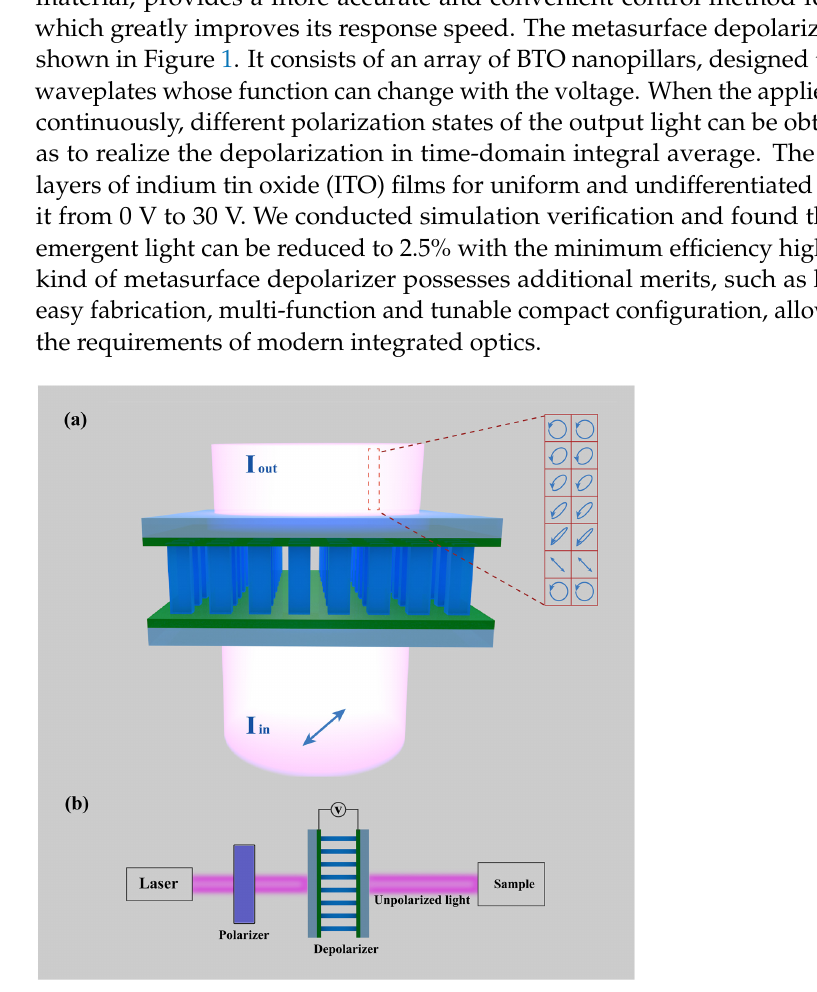
Figure 1. The schematic of the metasurface depolarizer. ( a ) The incident light is linearly polarized light with polarization direction angle π= 4 α , and after passing through the metasurface depo- larizer, the emergent light obtained a low DoP with random states of polarization. ( b ) Example of general use of